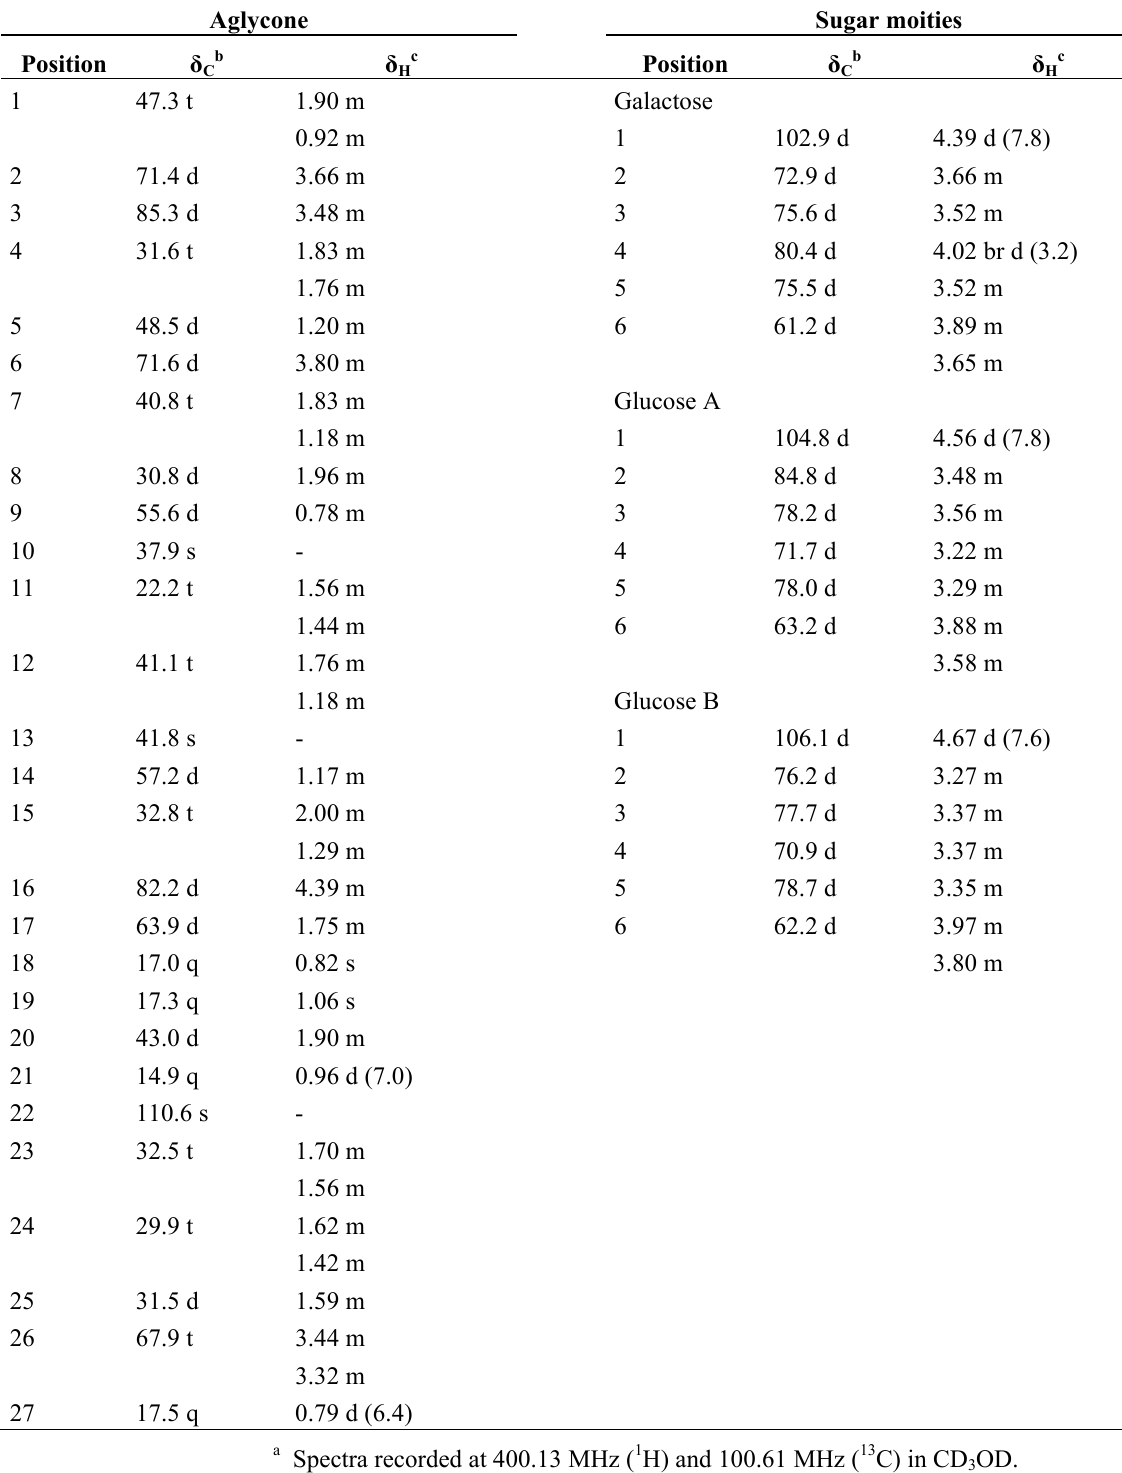
Table 3 . NMR spectroscopic data of compound